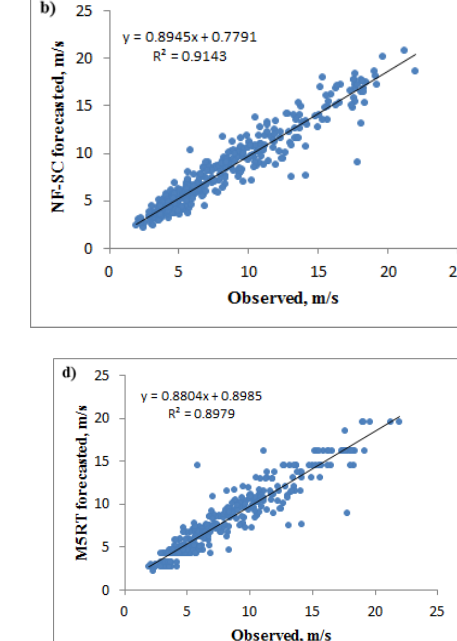
Figure 6. The scatterplots of the observed and predicted wind speeds using the ( a ) NF grid partition (NF-GP),( b ) NF sub-clustering (NF-SC), ( c ) LSSVR, and ( d ) M5RT models for the M4 dataset.